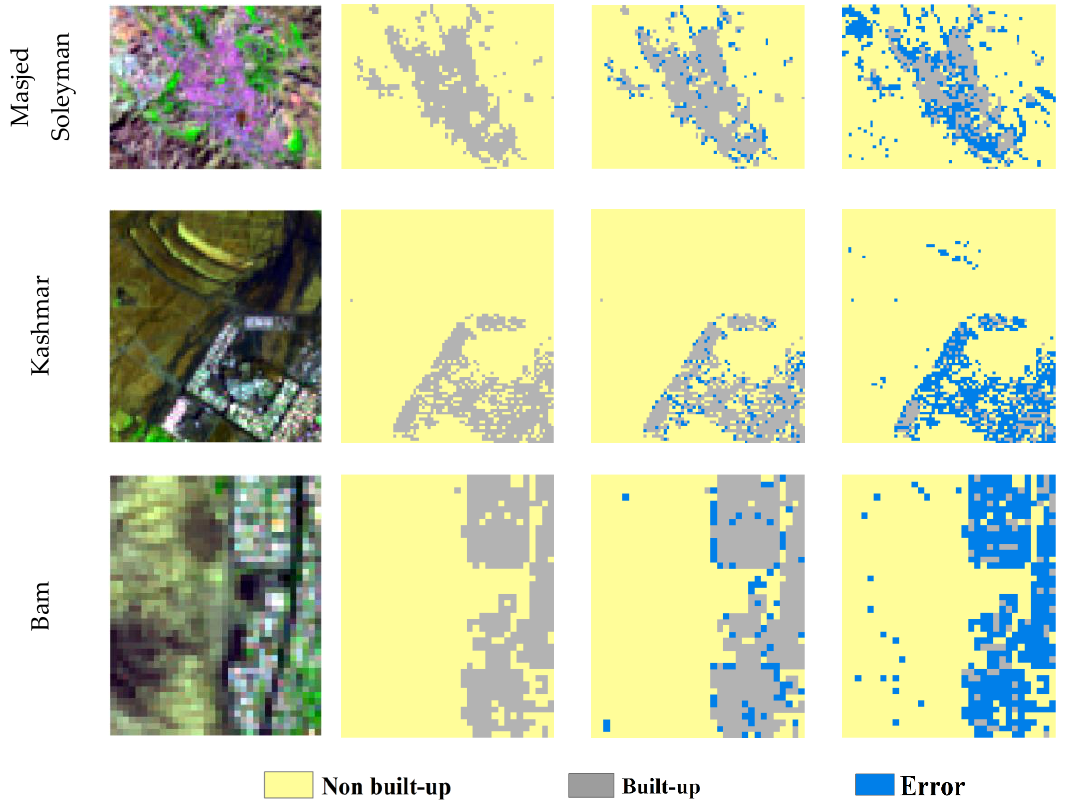
Figure 2. Comparison of the built-up extraction results using three classifiers at the five test sites.